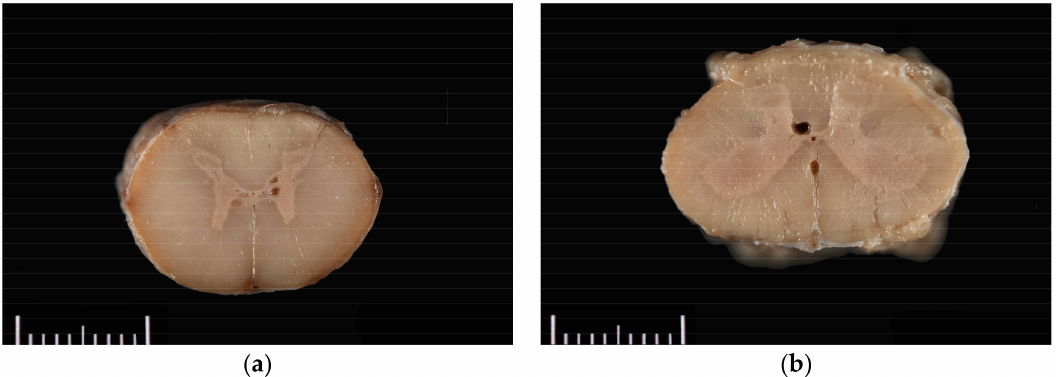
Figure 1. Grossly visible syrinxes within the grey commissures of the spinal cord at the level of ( a ) C5 and ( b )